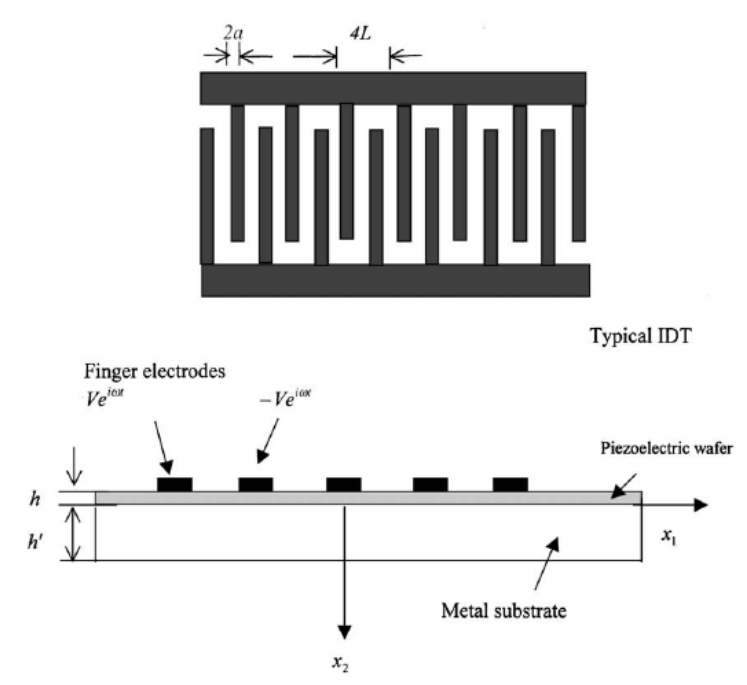
Figure 2. Piezoelectric coupled plate surface bonded by interdigital transducer (adopted from Figure 1 in